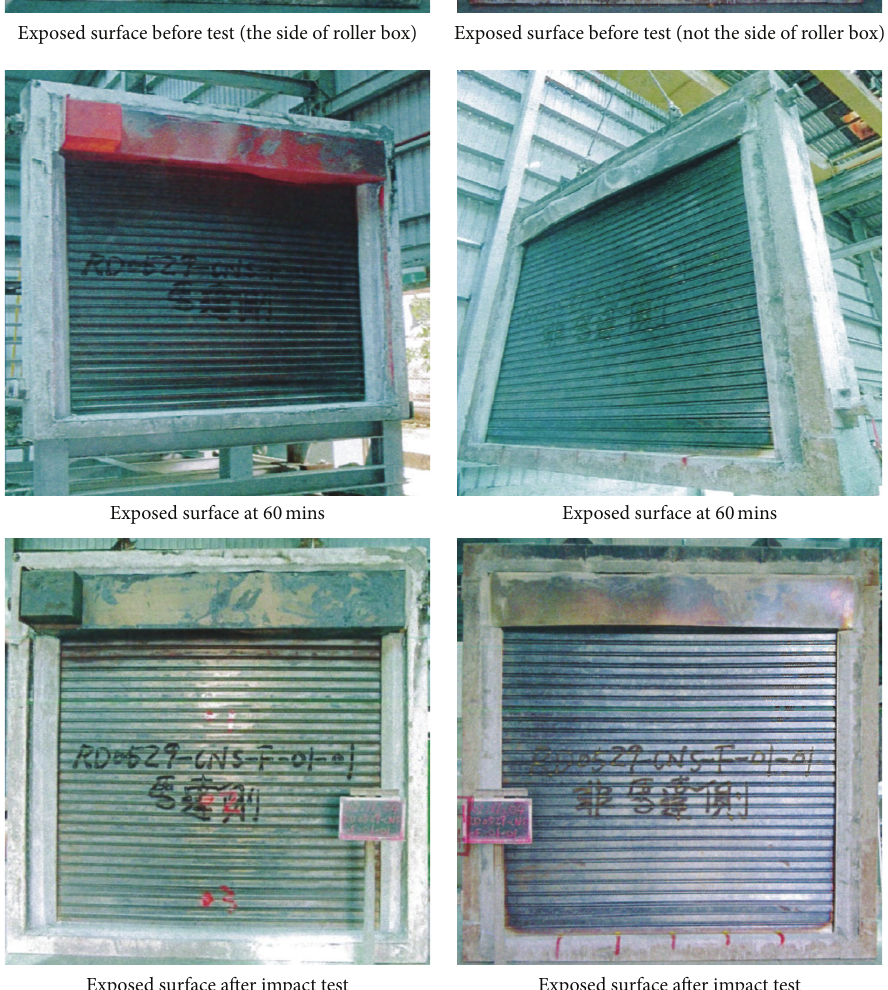
Figure 13: Exposed surface before heating test, at 60 mins, and after impact test with water film on exposed/unexposed surface.